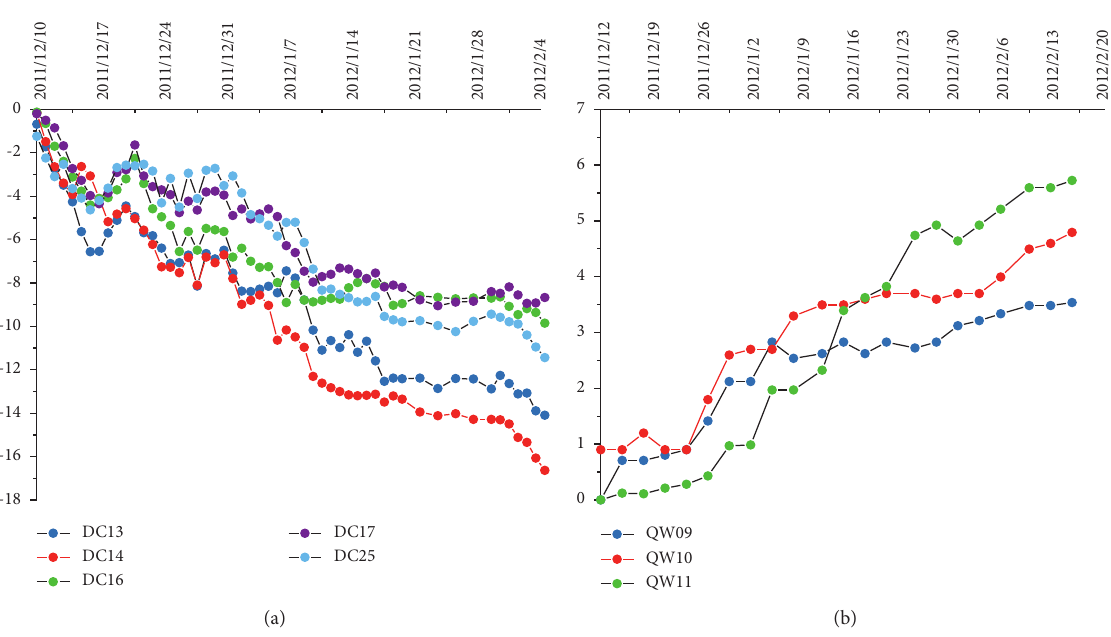
Figure 16: Typical time history curve of monitoring data. (a) Surface settlement. (b) Horizontal displacement of pile